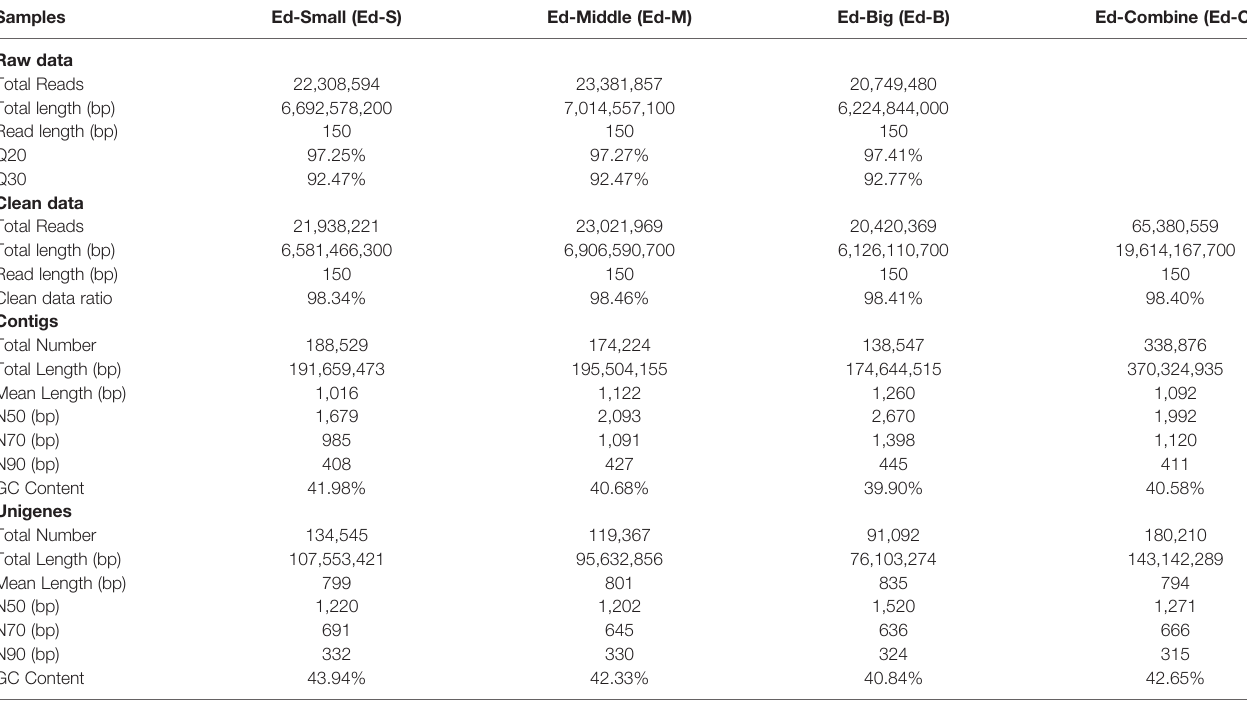
TABLE 1 | Sequencing statistics and assembly summary of sea anemone transcriptome.